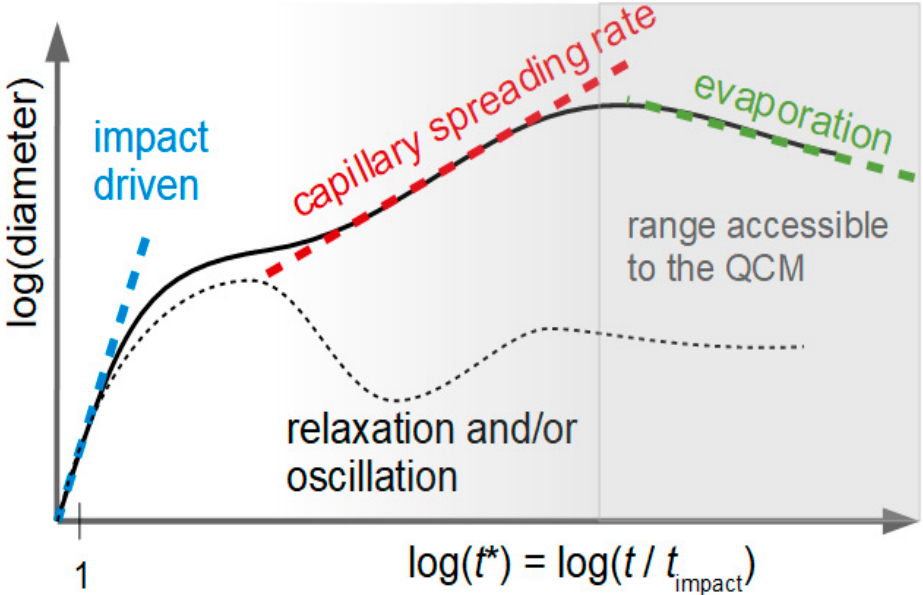
Figure 2. Different phases of the droplet deposition process. The immediate impact happens on the time-scale of a few microseconds. Inertial forces dominate, but viscosity and surface energy synergistically prevent splashing. After the impact, the drop may or may not undergo oscillations in shape. There usually is some further spreading, meaning that the contact line moves outwards. If the contact line in the final state is pinned, the droplet radius eventually stays constant. Otherwise, the droplet will shrink in diameter. Droplet drying may occur within less than a second. This was adapted from Reference [26] and slightly modified to include drying and the time range accessible to the QCM.